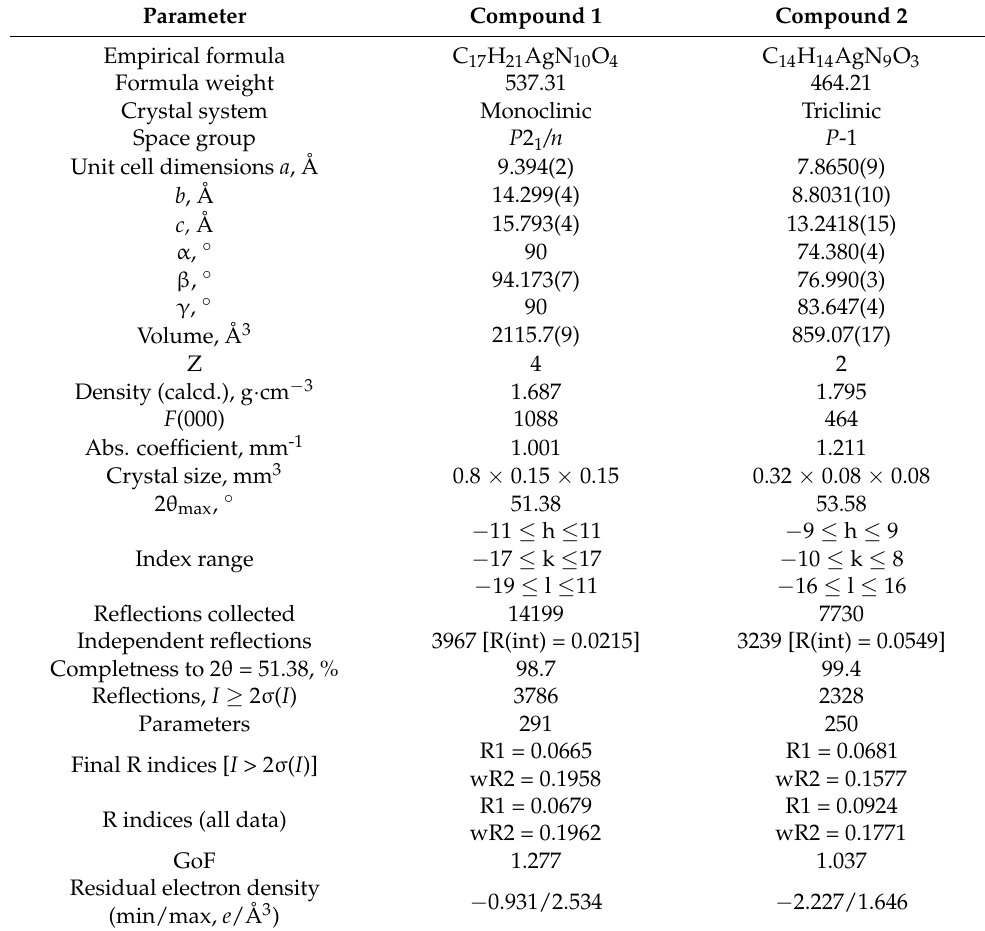
Table 2. Crystallographic data for compounds 1 and 2